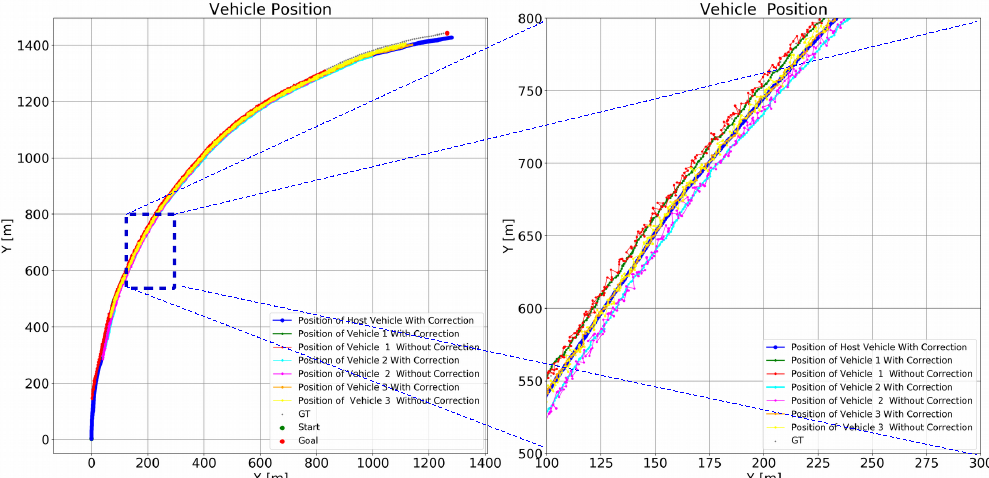
Figure 5. Experiment II (trajectory estimation in simulation) results. Global location of the host vehicle and three target vehicles with different speeds are shown. The host and three target vehicles followed the gray paths. Absolute trajectory estimates are biased because of accumulated host vehicle positioning error. Noise was added to optical flow and the detected relative positions of the target vehicles. The blue path shows the estimated host vehicle path.